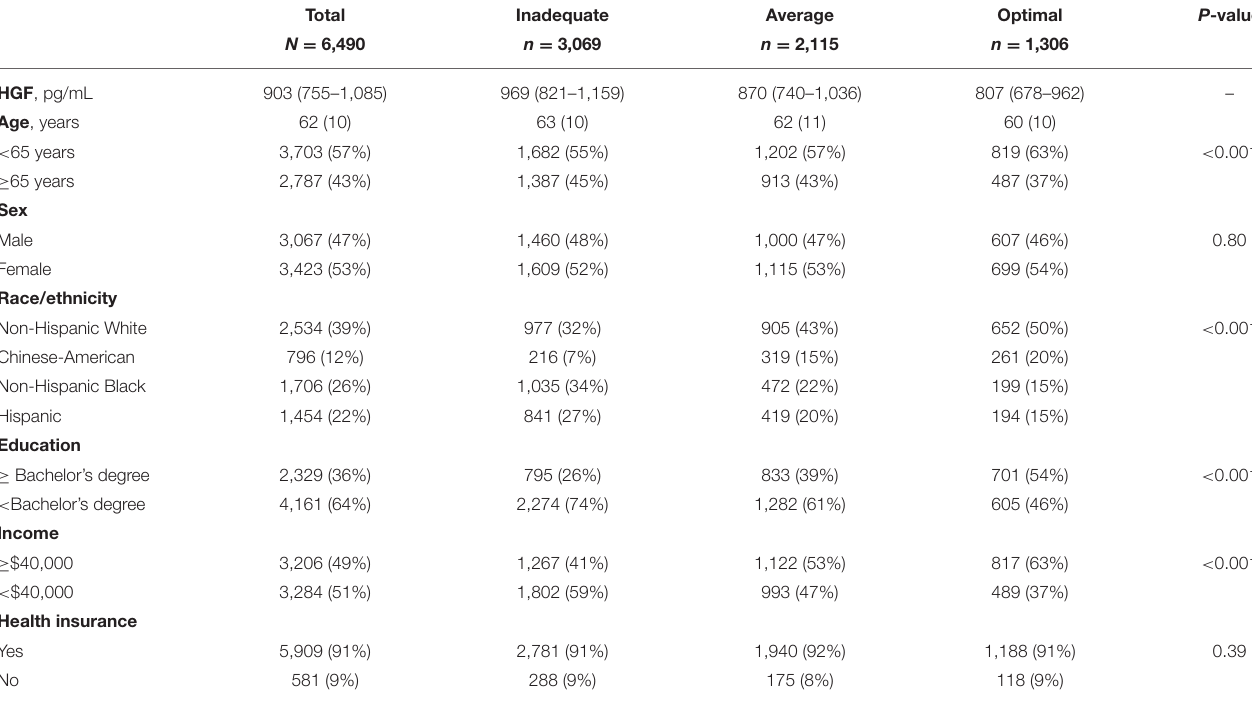
TABLE 1 | Characteristics of study participants at the MESA baseline exam (2000–2002) by cardiovascular health